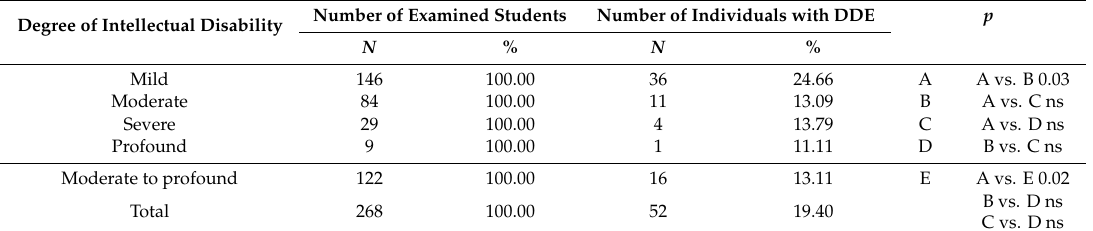
Table 2. Number of special-care students with developmental defects of enamel (DDE) with respect to degree of their intellectual disability.